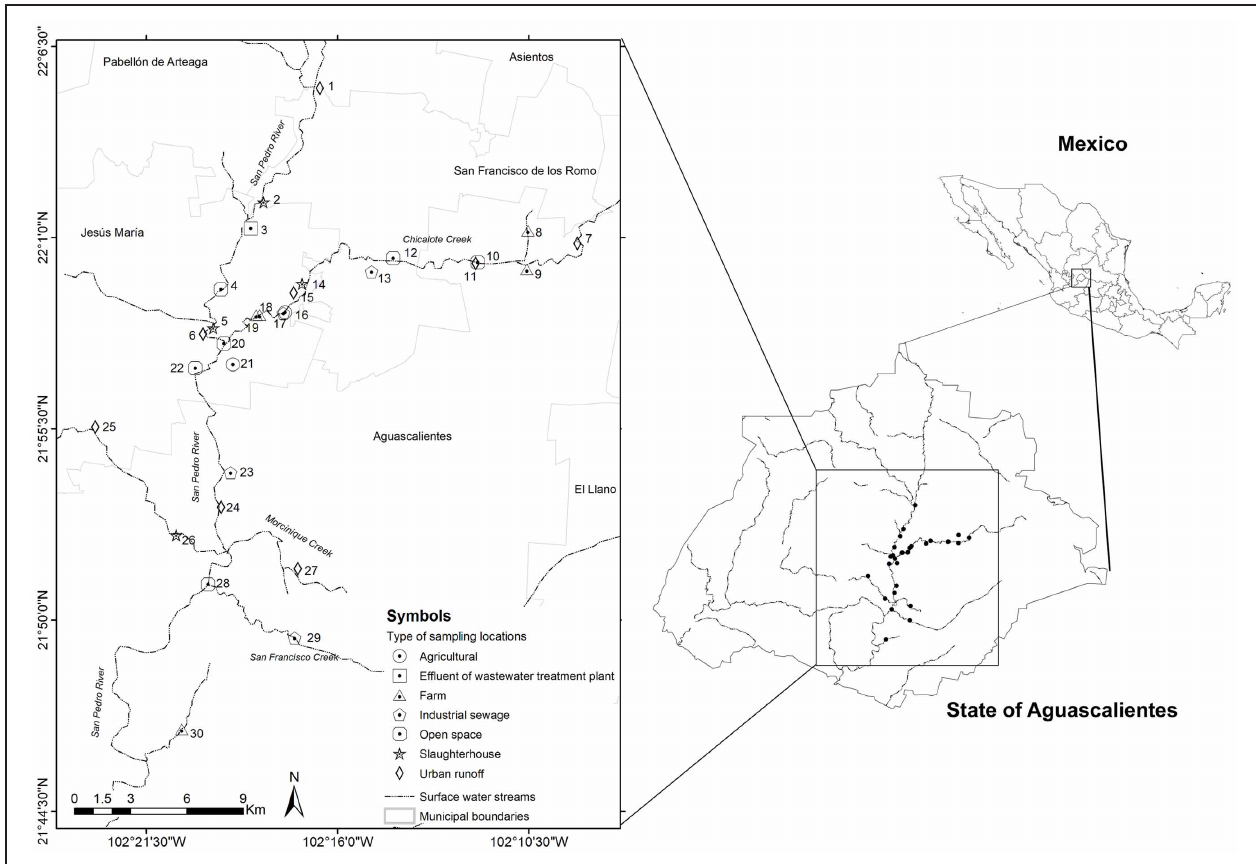
FIGURE 1 | Diagram of sample locations along the San Pedro River. Chicalote, Morcinique, and San Francisco Creek are the main tributaries of the San Pedro